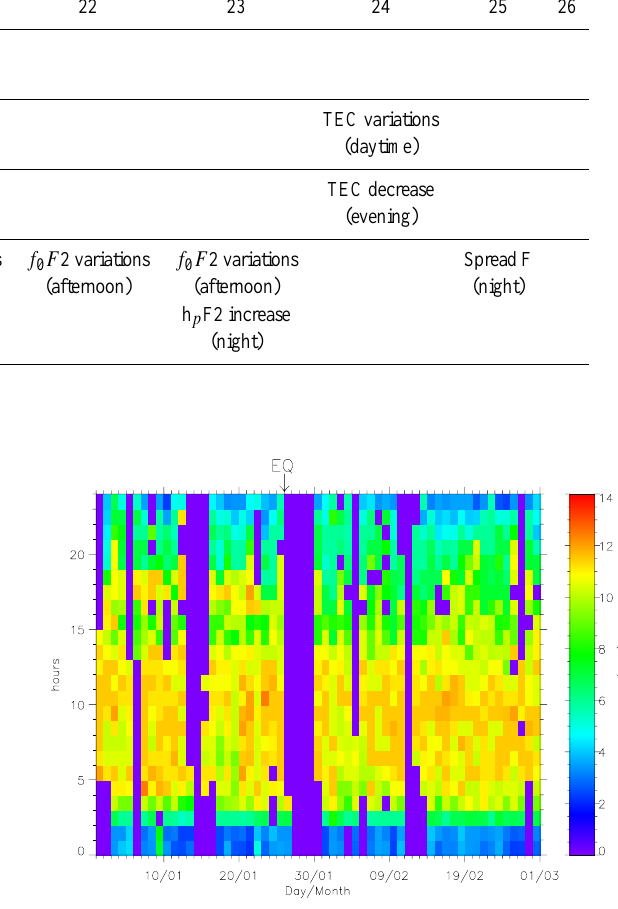
Fig. 9. Hourly variations of foF2 in UT at the Ahemadabad iono- spheric station during January and February 2001. The data are color-coded according to the scale on the